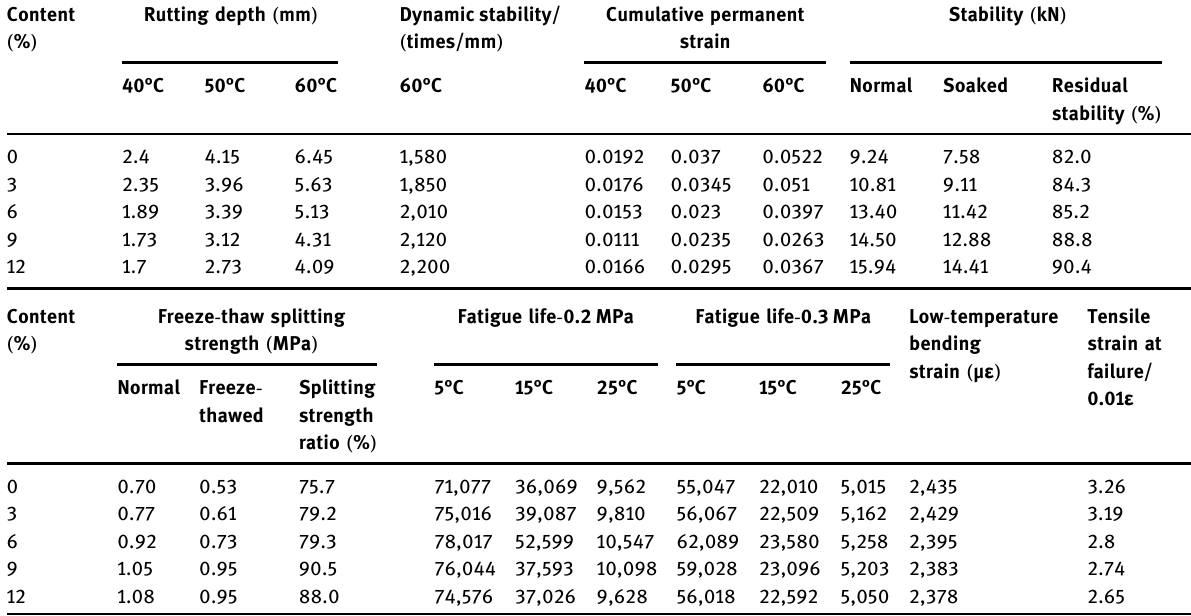
Table 4: Raw data of various performances Content Rutting depth ( mm ( % )